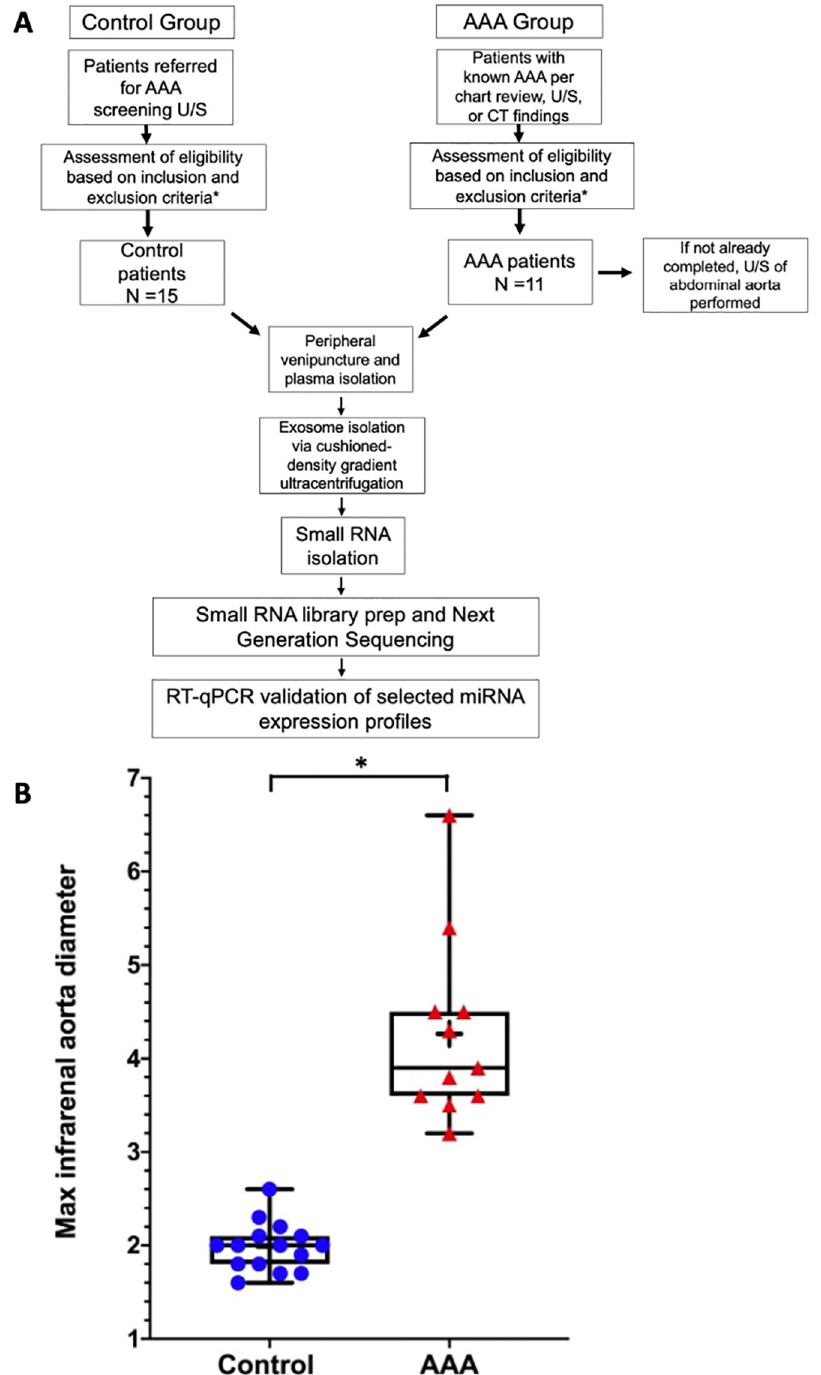
Fig 1. Flow diagram of patient selection and study design ( A ). Box and whisker plot showing maximum infrarenal aorta diameter of each patient enrolled in the study ( B ). AAA, abdominal aortic aneurysm; US, ultrasound; CT, computed tomography; qRT-PCR, quantitative real-time